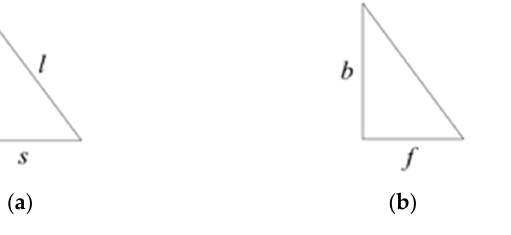
Figure 2. Demonstrations of edge usage. ( a ) l and s for the watermark index; ( b ) b and f for the watermark bit.